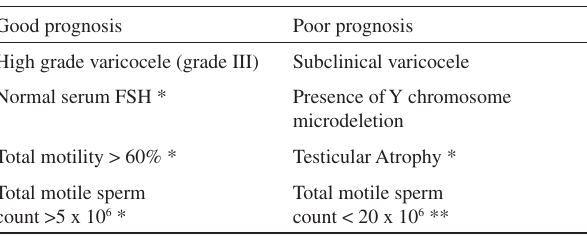
Table 1 - Predictors of varicocele repair outcomes in infertile